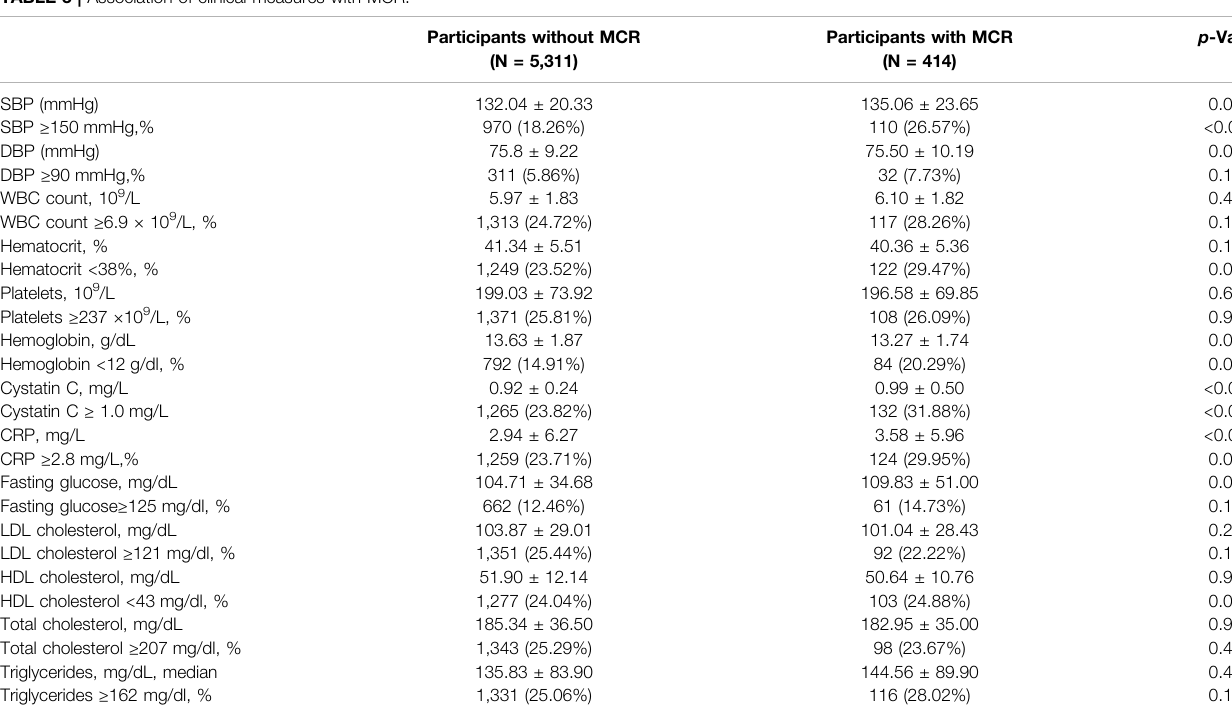
TABLE 3 | Association of clinical measures with